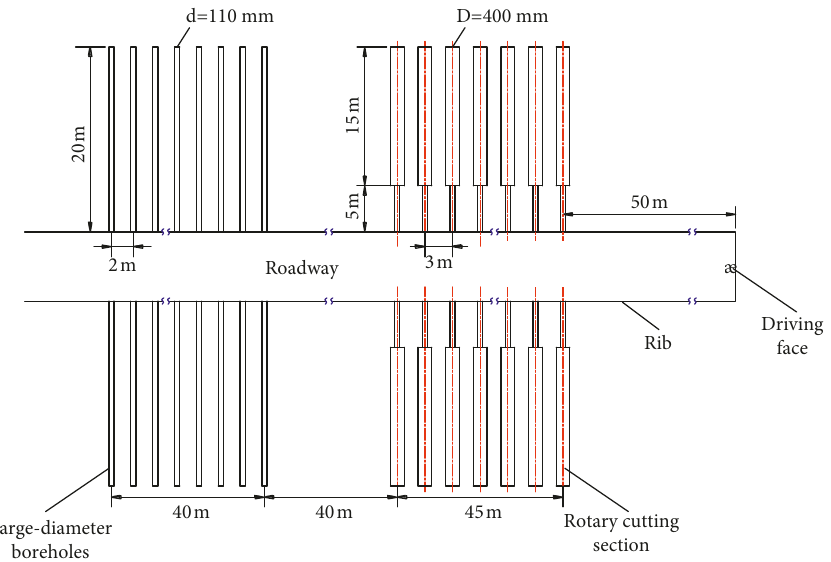
Figure 18: The specific on-site implementation